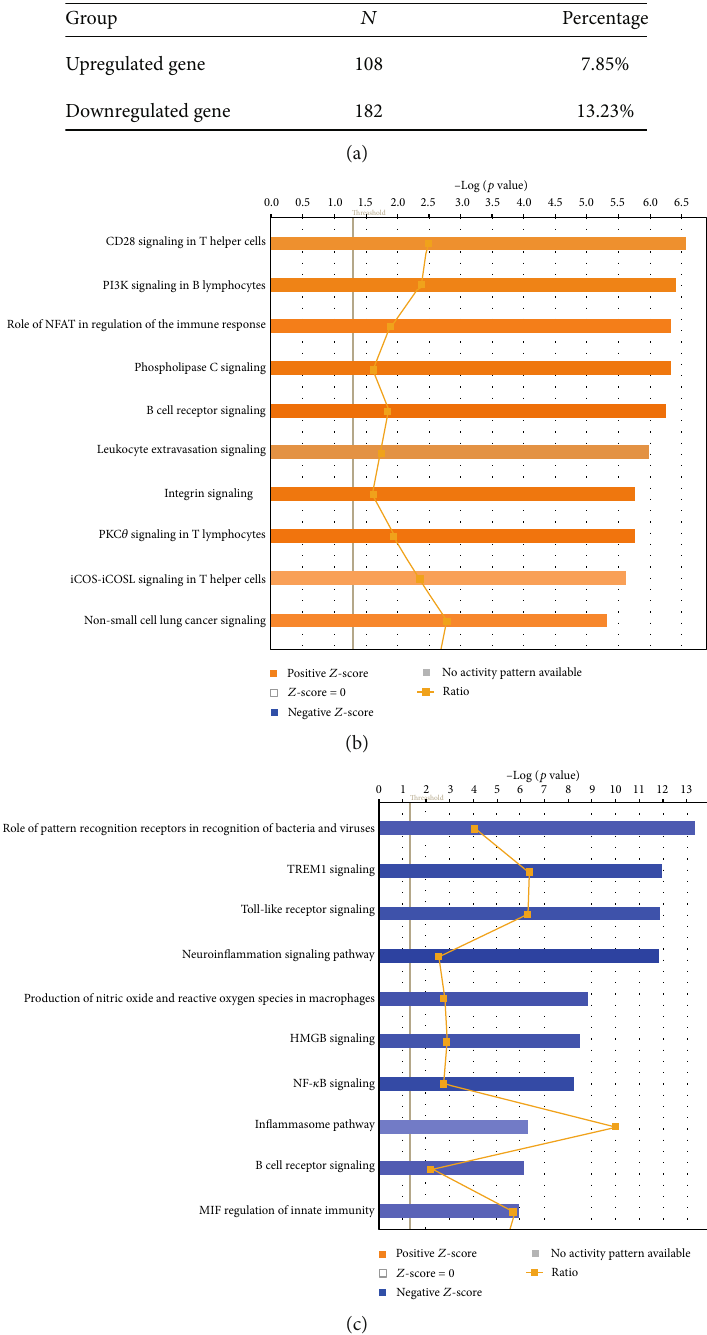
Figure 3: (a) Low-intensity ultrasound (LIUS) upregulated 108 out of 1376 (7.9%) innate immunome genes and downregulated 182 out of 1376 (13.2%) innate immunomic genes in rat bone marrow cells (GSE70662), suggesting that LIUS suppresses innate immunomic gene expressions more than it increases them in bone marrow cells. The LIUS-modulated genes are listed in Supplemental Table 3. (b) LIUS upregulated 108 genes that were signi fi cantly involved in 54 signaling pathways in bone marrow cells. The top ten pathways include CD28 signaling in T cells, PI3K signaling in B lymphocytes, the role of NFAT in regulation of immune responses, phospholipase C signaling, B cell receptor signaling, leukocyte extravasation signaling, integrin signaling, PKC zeta signaling in T lymphocytes, ICOS-ICOSL signaling in T helper cells, and non-small-cell lung cancer signaling. (c) LIUS downregulated 182 genes that were signi fi cantly involved in 70 signaling pathways in bone marrow cells. The top ten pathways include the role of pattern recognition receptors, TREM1 signaling, Toll-like receptor signaling, neuroin fl ammation signaling, production of nitric oxide and reactive oxygen species (ROS) in macrophages, HMGB1 signaling, NF- κ B signaling, in fl ammation pathway, B cell receptor signaling, and MIF regulation of innate immunity. These results suggest that LIUS inhibits numerous key innate immunity and in fl ammation pathways in bone marrow cells, which may be responsible for LIUS therapeutic e ff ects of in fl ammation suppression since nine out of the top ten pathways are related to danger signal recognition and in fl ammation